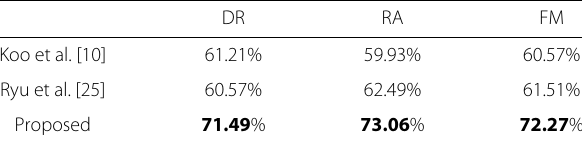
Table 6 Experimental results on the ICDAR 2015 dataset [18] with conventional textline detection